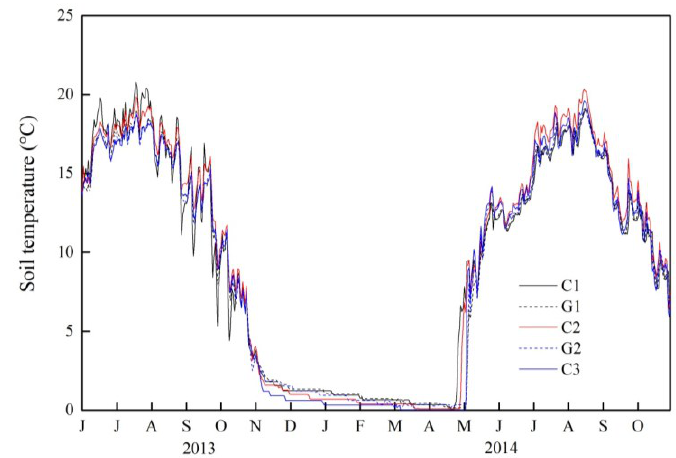
Figure 4. Temporal changes in soil temperature ( T s ) at a depth of 5 cm in gap and canopy areas.